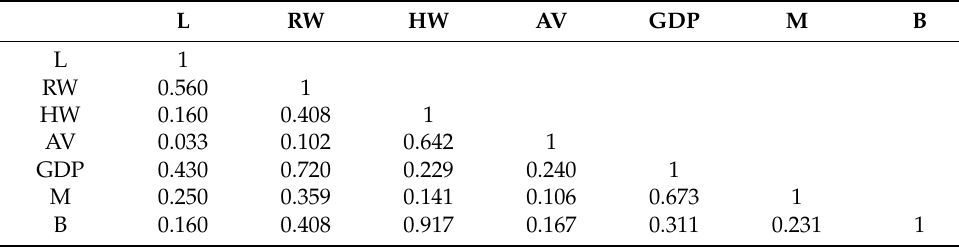
Table 3. Correlation coefficient matrix of explanatory variables.